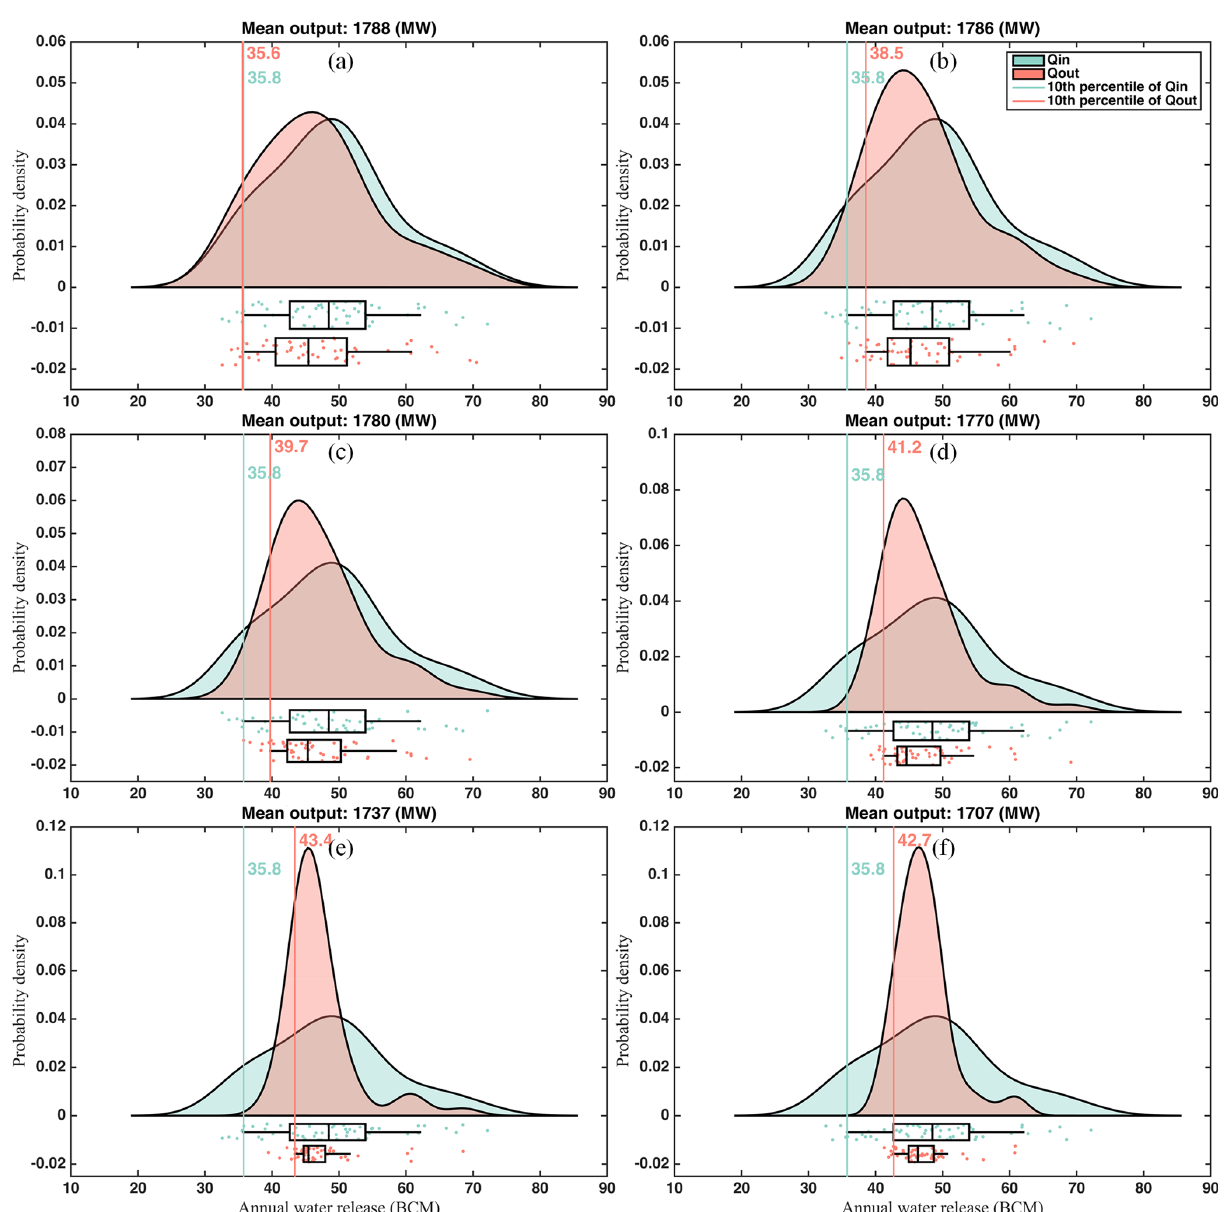
Figure A2. Kernel distribution of annual reservoir inflow ( Q in ) and water release ( Q out ) under different power generation levels (1965– 2017). Vertical lines represent the 10% exceedance